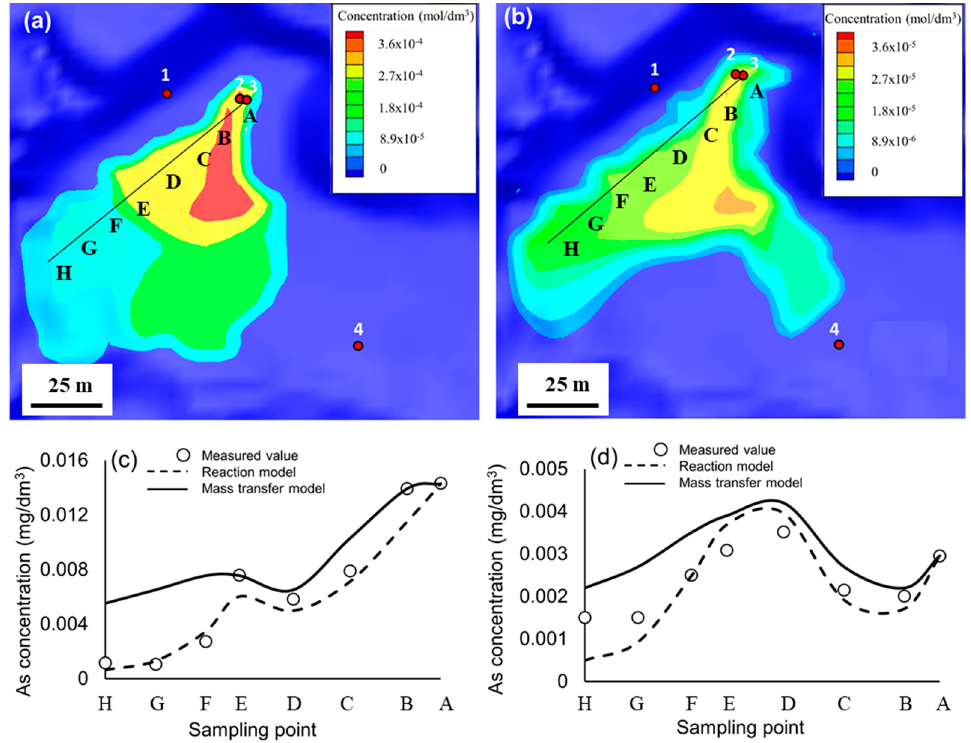
Figure 8. Simulation result: Distribution map of As concentrations ( a ) in summer, ( b ) in winter, and ( c , d ) measured Si concentrations on lines A–H and the fitting results.